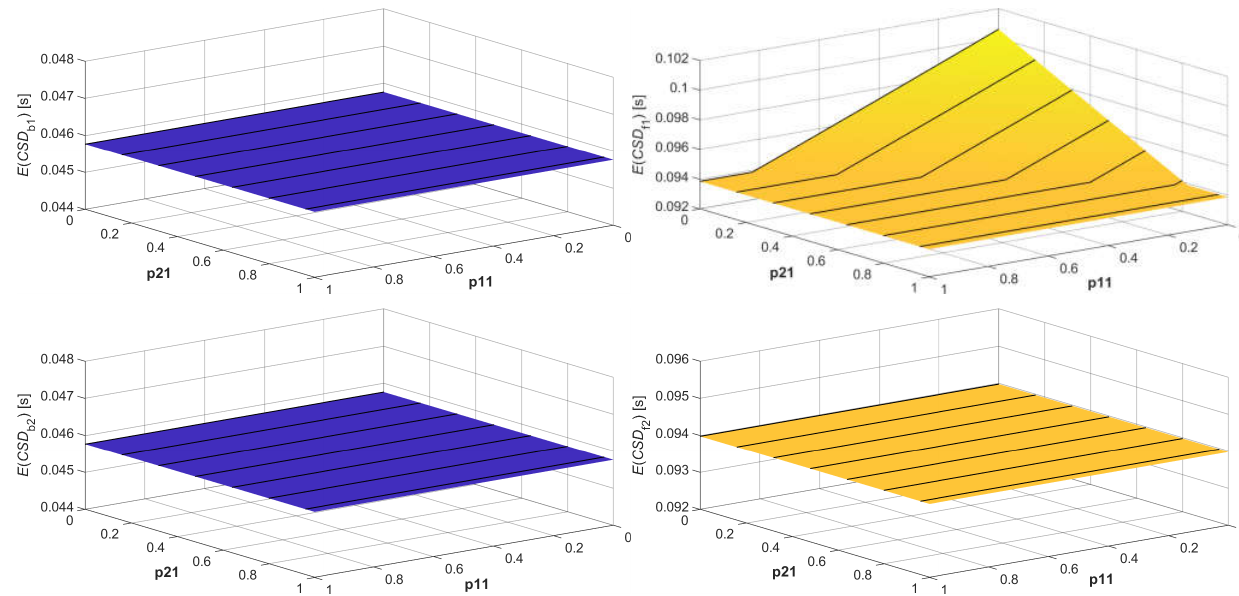
Figure 10. Selected results for data set 7 from Table 1.